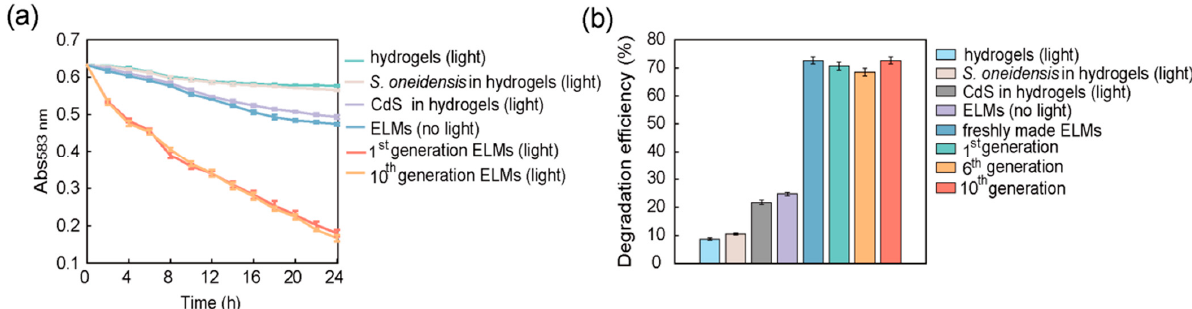
Figure 8. Assessment of the regenerative properties of engineered living materials (ELMs): ( a ) Change in concentration of trypan blue after treatment with the 1st and 10th generation of regenerated ELMs. Live cells were extracted from recycled ELMs and used to regenerate bacterial culture for the biosynthesis of nano-bacteria hybrids. The as-prepared nano-bacteria hybrids were encap- sulated in alginate hydrogels to regenerate ELMs. The regeneration process was repeated for 10 generations; ( b ) The concentration of trypan blue after 24 h of treatment was compared with the initial concentration to assess the trypan blue degradation efficiency. The concentration was deter- mined by comparing it to a trypan blue calibration curve generated based on Abs 583 nm . Regenerated ELMs exhibited photocatalytic degradation efficiency comparable to that of freshly prepared ELMs. No